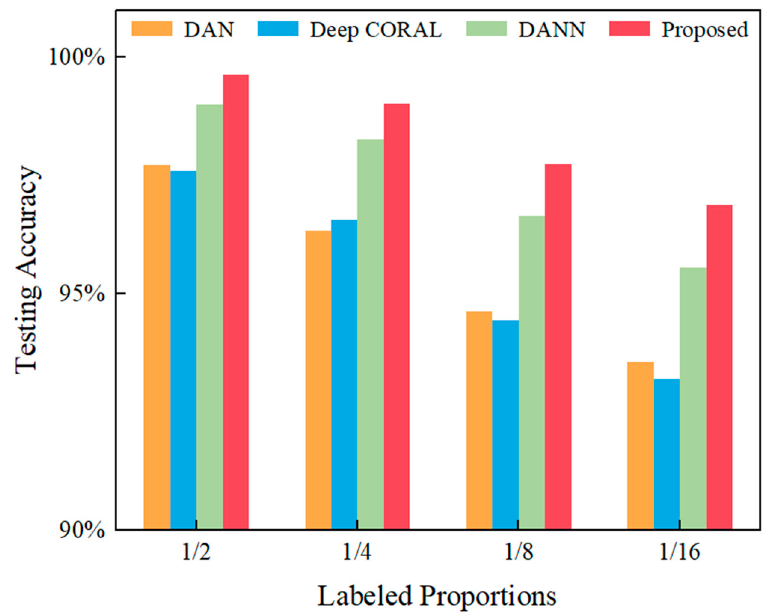
Figure 14. Comparison of contrast test accuracy.